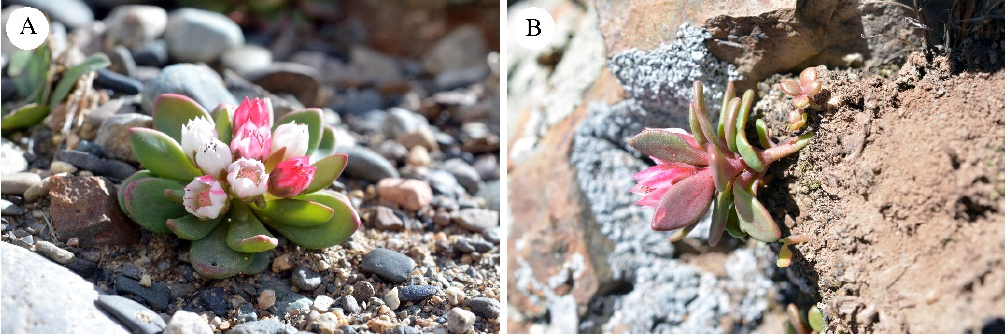
Figure 8. Rhodiola namlingensis S.Y. Meng. ( A ). A plant and its habitat; ( B ). Side face of the plant.